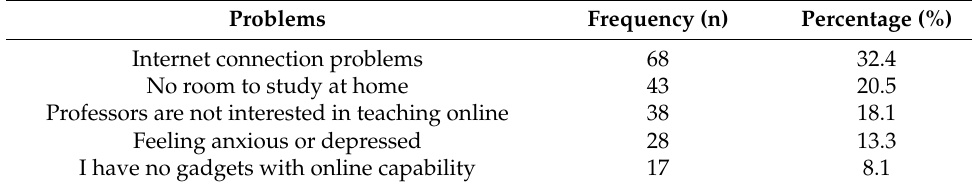
Table 9. Problems related to the study during the